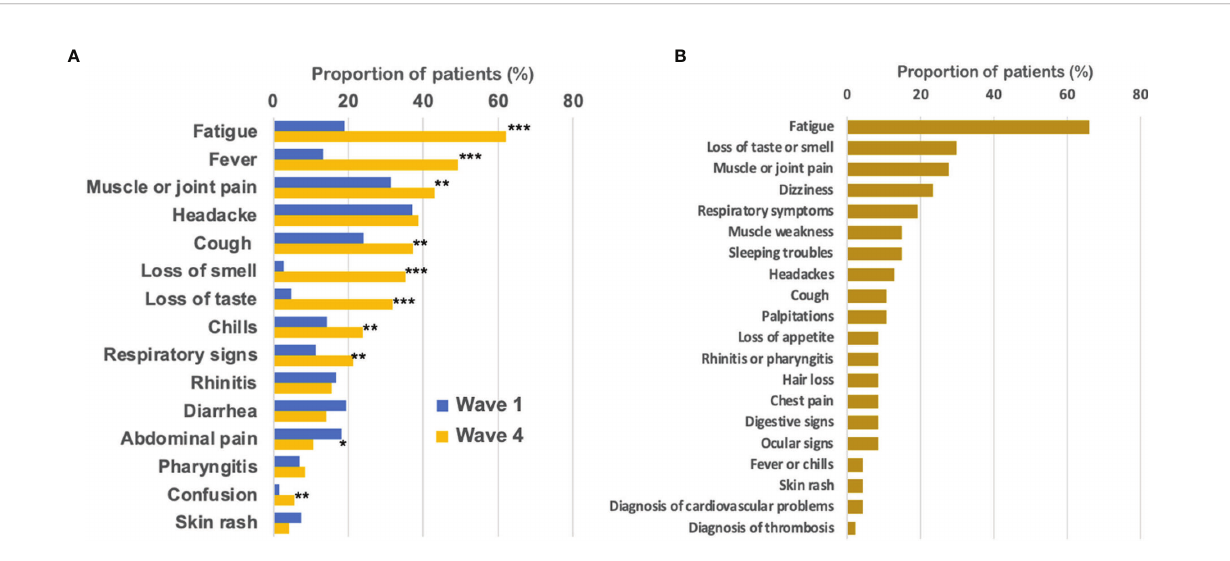
FIGURE 4 | Clinical patterns of mild COVID-19 infection. (A) Symptoms associated with COVID-19 experienced by cancer patients in cohort 1 during wave 1 (in blue) and wave 4 (in orange). (B) Long-lasting COVID-19 symptoms among cohort 2 patients (at wave 4). *p<0.05; **p<0.01;